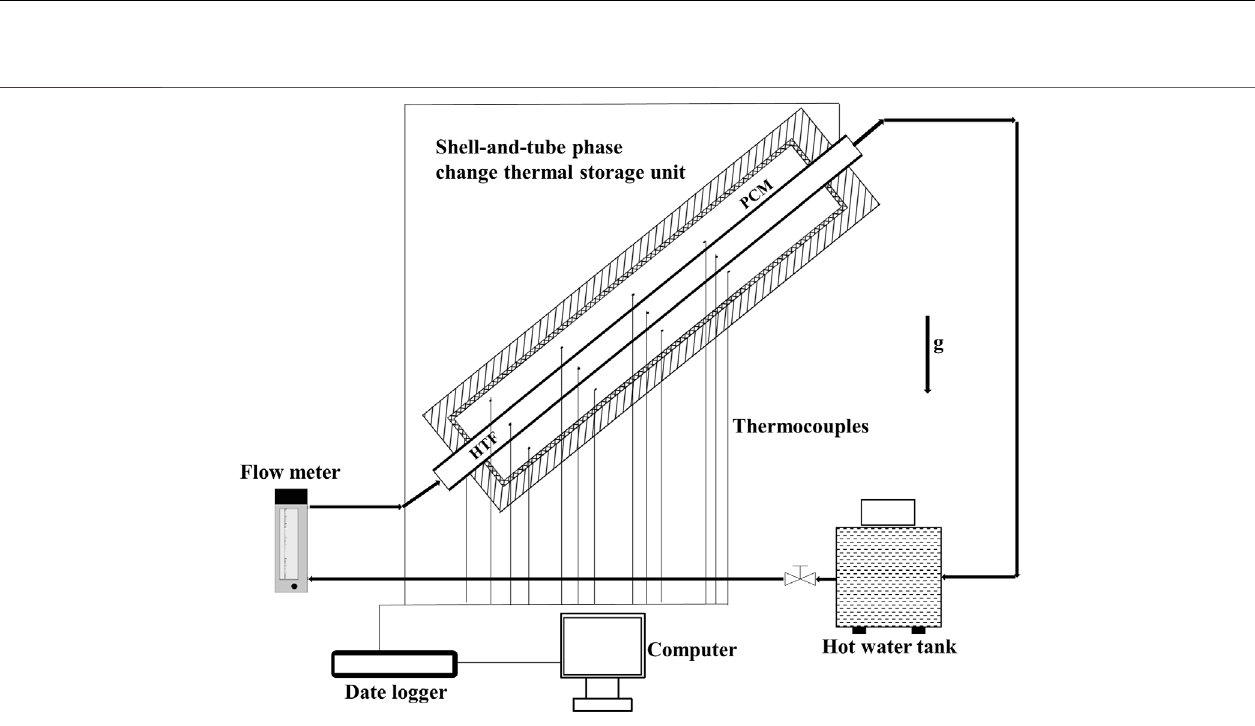
tube phase-change heat storage units at different inclined angles. The temperature changes under different conditions are obtained using thermocouples placed inside the heat